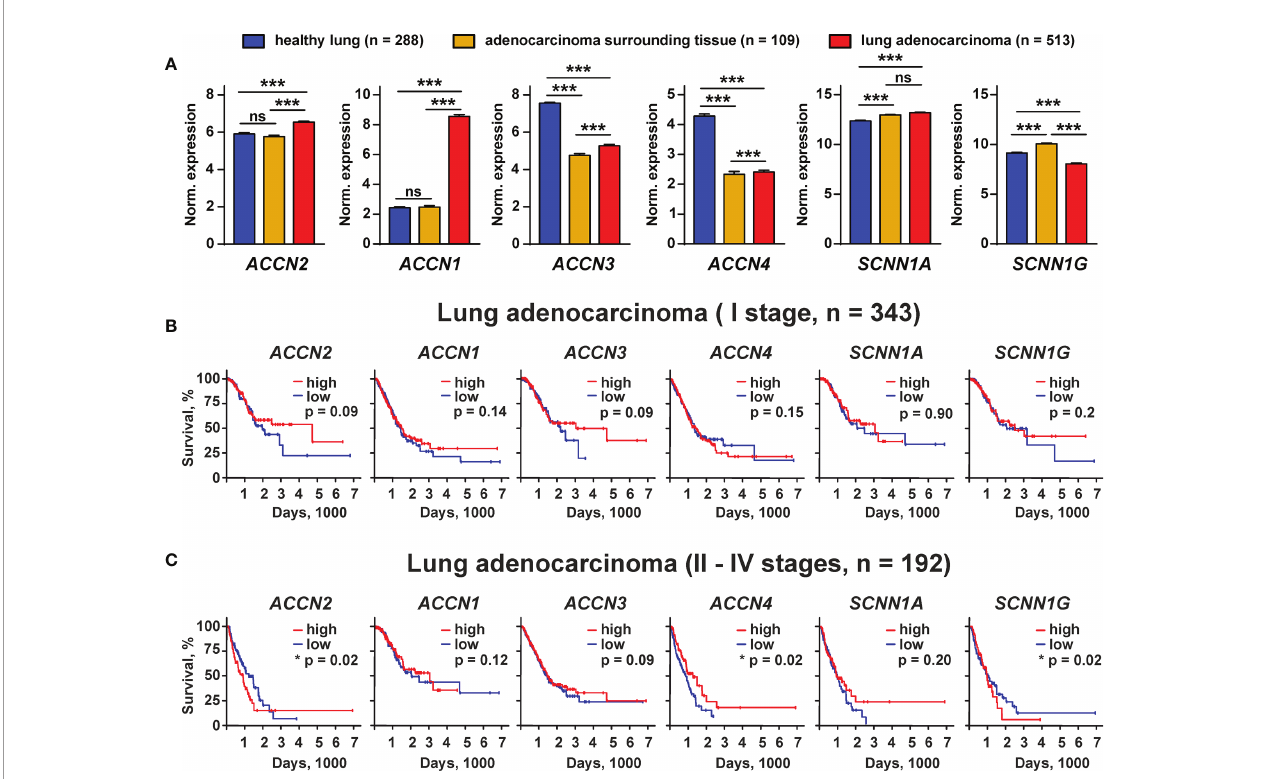
FIGURE 9 | Bioinformatic analysis of the ACCN2 , ACCN1 , ACCN3 , ACCN4 , SCNN1A , and SCNN1G expression in healthy people and patients with lung adenocarcinoma from the GTEX and TCGA LUAD databases. (A) Analysis of the gene expression in healthy lung biopsies (GTEX study) and in samples of lung adenocarcinoma surrounding tissue, and lung adenocarcinoma specimen (TCGA LUAD study). Data are presented as normalized gene expression ± SEM; *** (p < 0.001) indicates signi fi cant difference between the data groups by one-way ANOVA followed by Tukey ’ s post-hoc test. (B, C) Kaplan – Meier analysis of the correlation between survival of the patients with lung adenocarcinoma at I (B) and II – IV stages (C) and different expressions of the ACCN2 , ACCN1 , ACCN3 , ACCN4 , SCNN1A , and SCNN1G genes. * (p <0.05) indicates signi fi cant difference between the overall survival prognosis for patients with the high (above median) and low (below median) gene expressions according to the log-rank test, n.s. - no signi fi cant difference (p>0.05).